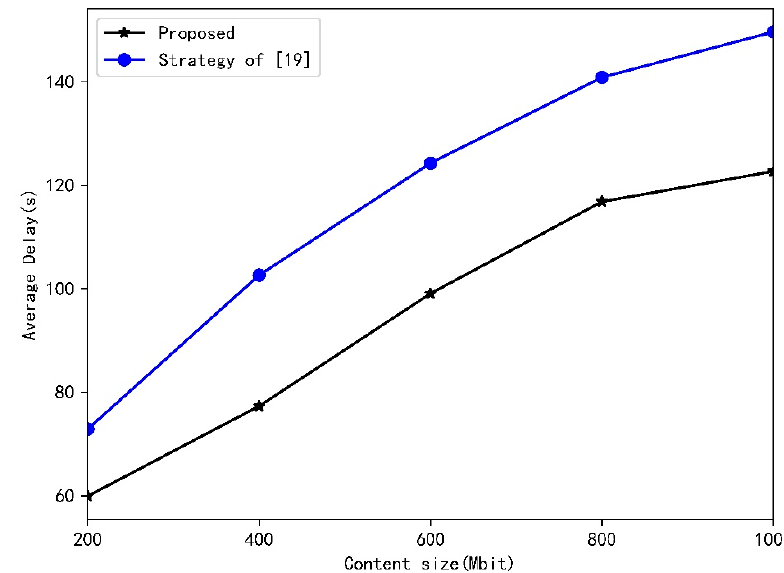
Figure 7. The relationship between the Average Delay and content size.